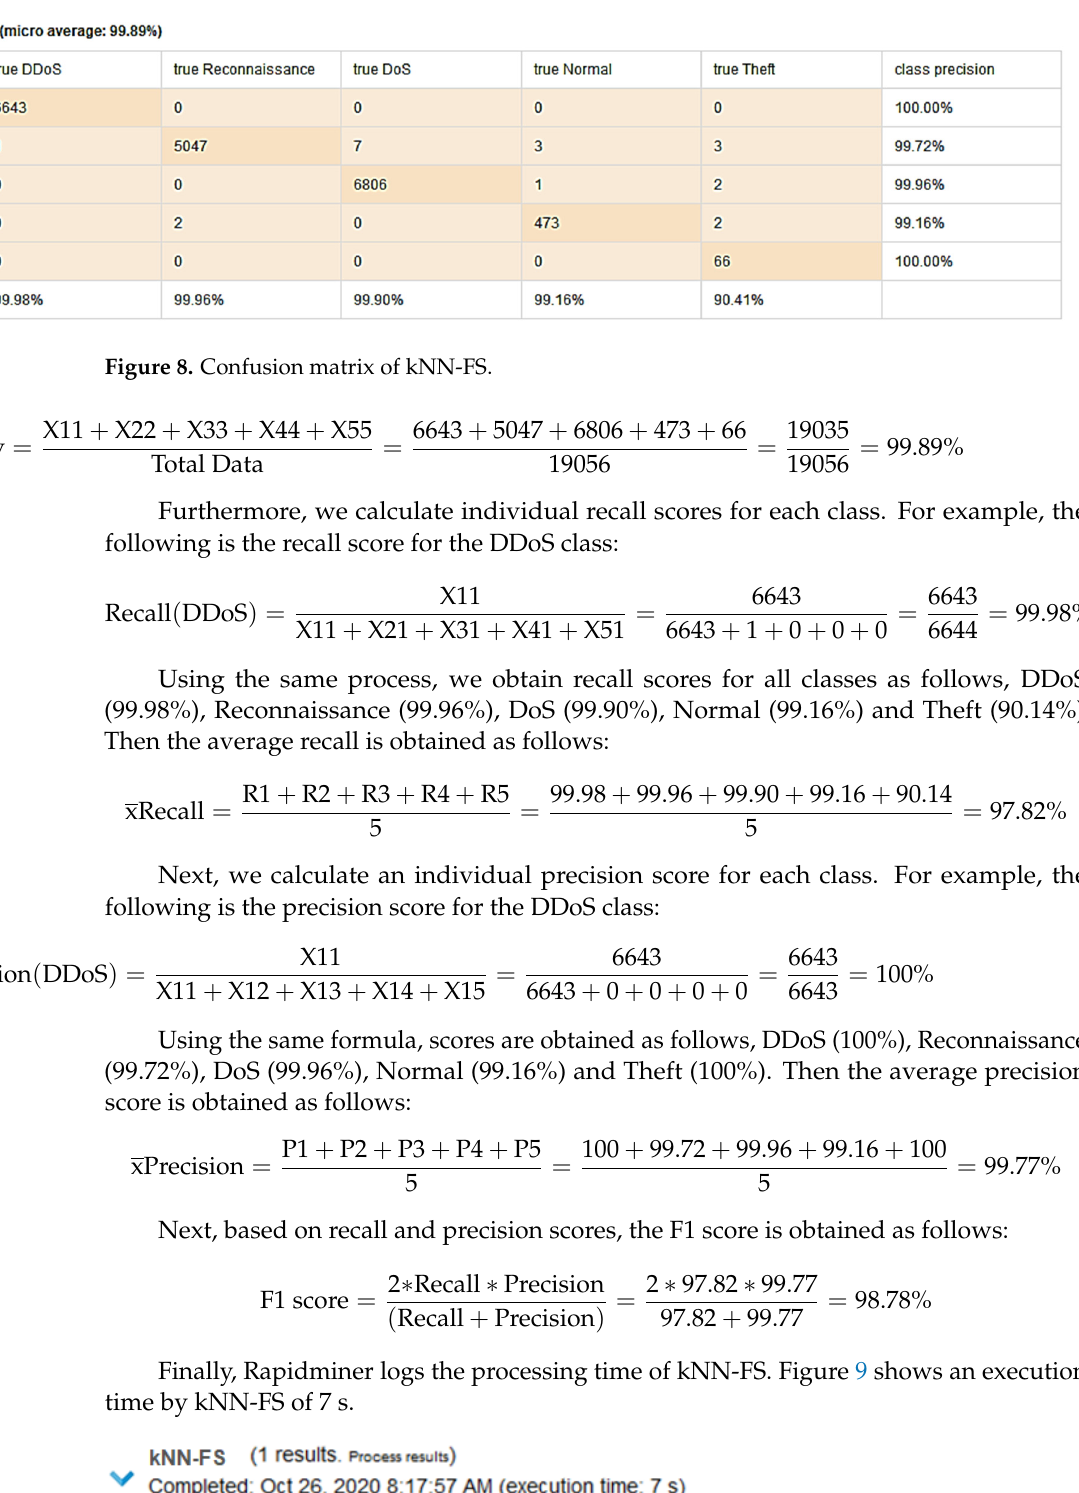
11 of 19 Figure 6. Execution time for kNN-IG. 4.2. kNN Algorithm with Forward Selection (kNN-FS) Forward Selection (FS) is the second feature selection technique applied to the dataset in order to measure the most influential features among existing features of the Botnet- IoT dataset. FS feature selection is classified as the Wrapper method in Rapidminer. Figure 7 represents the process of FS implementation on the dataset in the Rapidminer environ- ment. Figure 7. Forward Selection. After the selection process is carried out, the number of the selected features by the Forward Selection technique is decreased, as can be seen in Table 4. Table 4. Reduced features by Forward Selection.